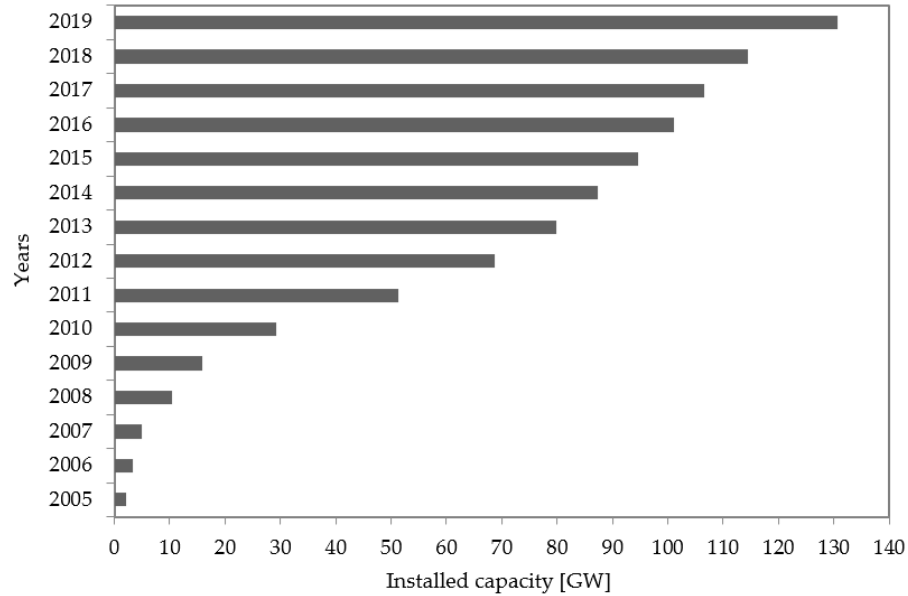
Figure 3. Photovoltaic installed capacity in Europe. Adapted from ref. [4].